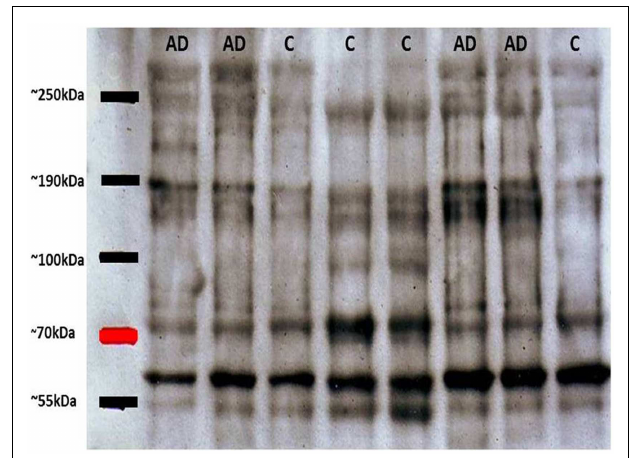
FIGURE 1 | Representative immunoblots of platelet tau with tau-5 antibody . High molecular weight tau bands (about 80kDa) can be appreciated, with greater immunoreactivity in patients with Alzheimer’s disease (AD) compared with control subjects (C). Subsequent densitometric analysis allows obtaining the relationship between HMWtau versus